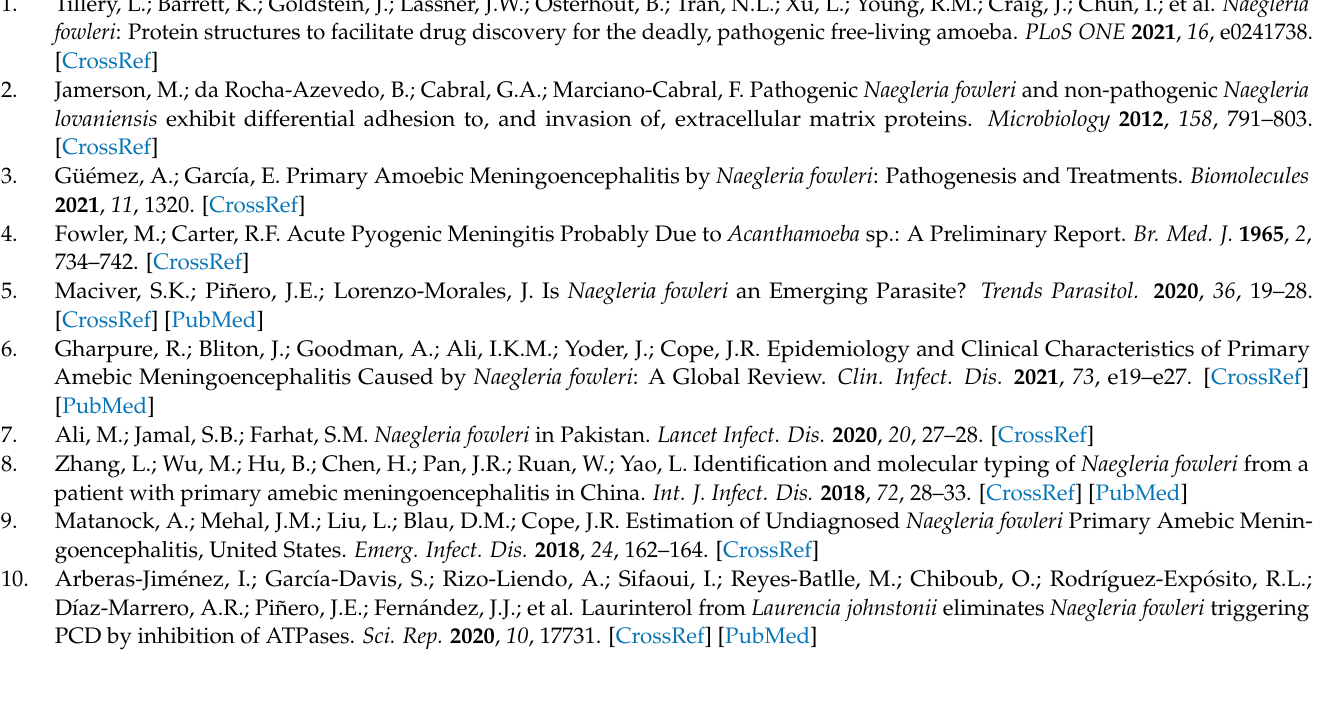
Higher magnification of Figure